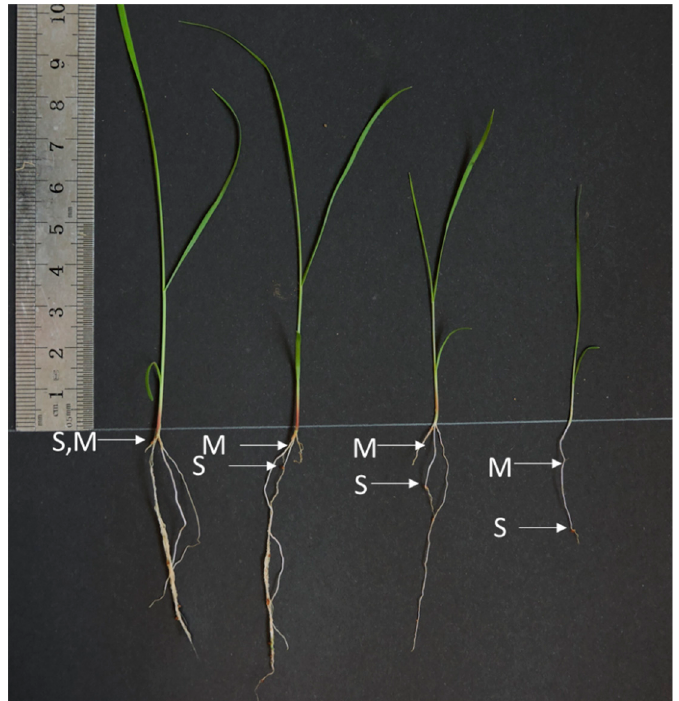
Figure 3. Tef seedlings sown at different depths (0, 1, 2, 3 cm). Seed locations (S) and mesocotyl (M) are marked by white arrows. Picture was taken upon appearance of fully expanded second leaf on the plant sown at 3 cm depth.